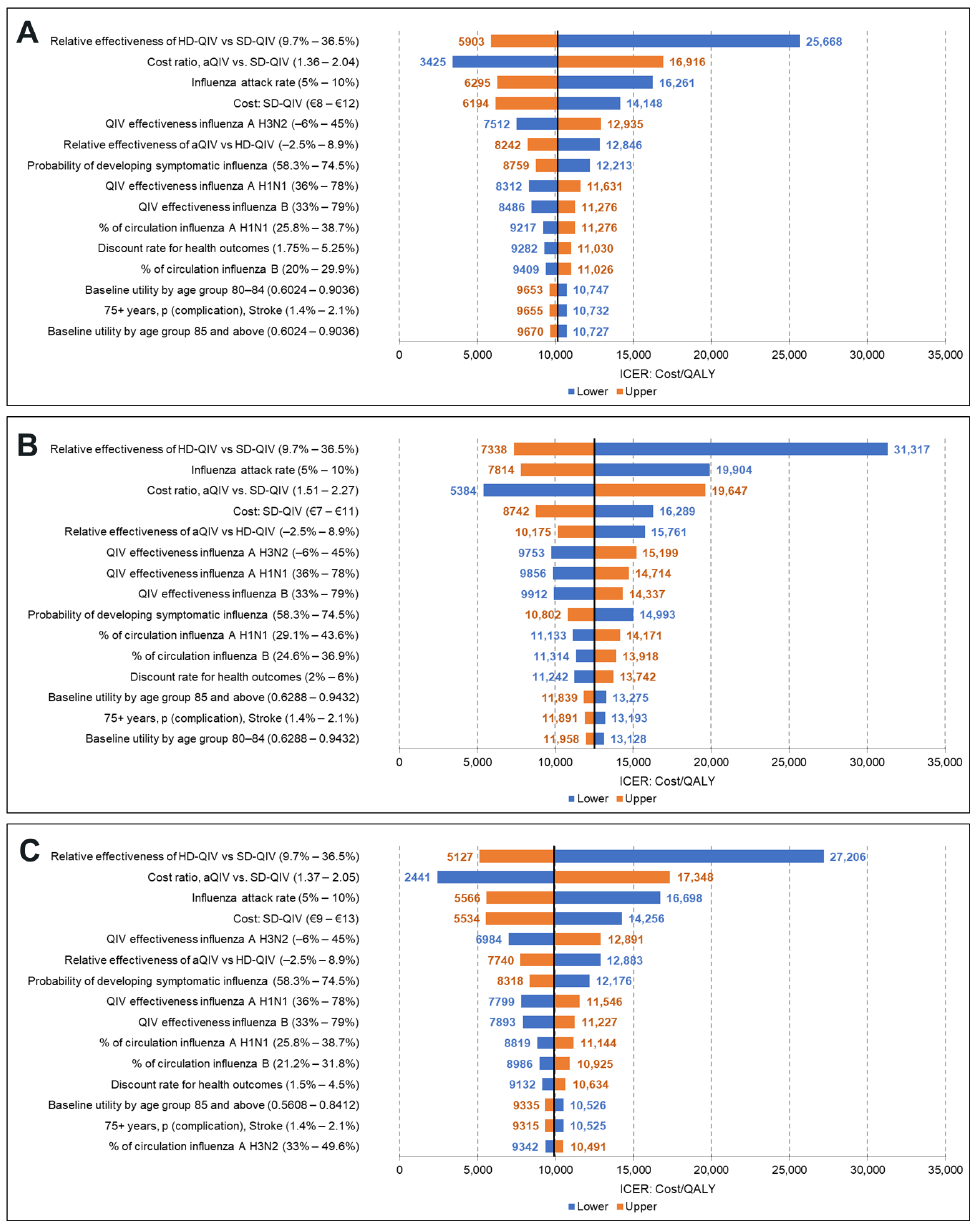
Figure 2. DSA results (aQIV vs. SD-QIV): ( A ) Denmark, ( B ) Norway, ( C ) Sweden. Table 6. Scenario analysis results (aQIV vs.